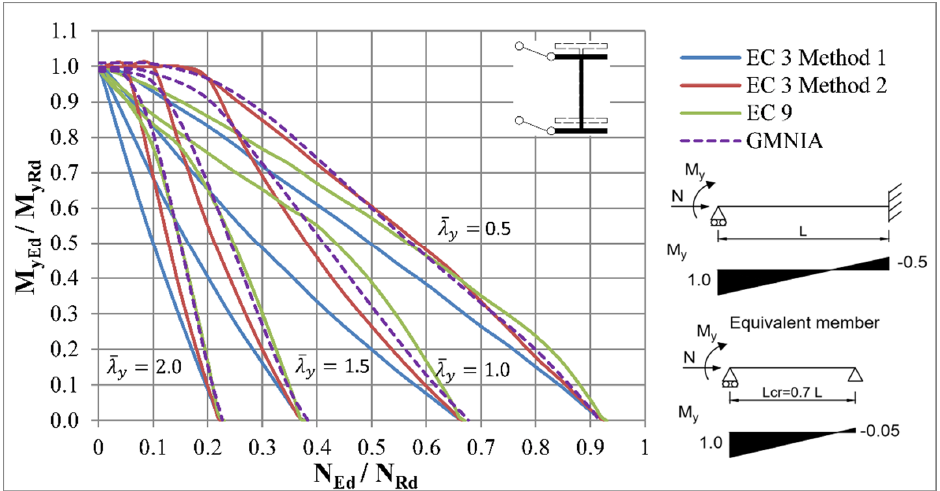
Figure 8. Interaction curves for laterally restrained beam-columns with IPE 100 cross-section.